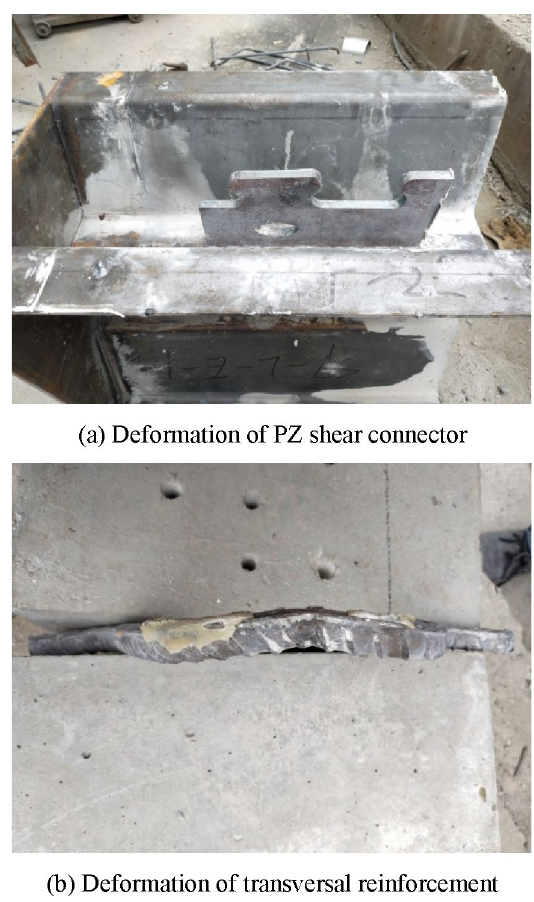
Figure 9. A specimen with PZ shear connector after